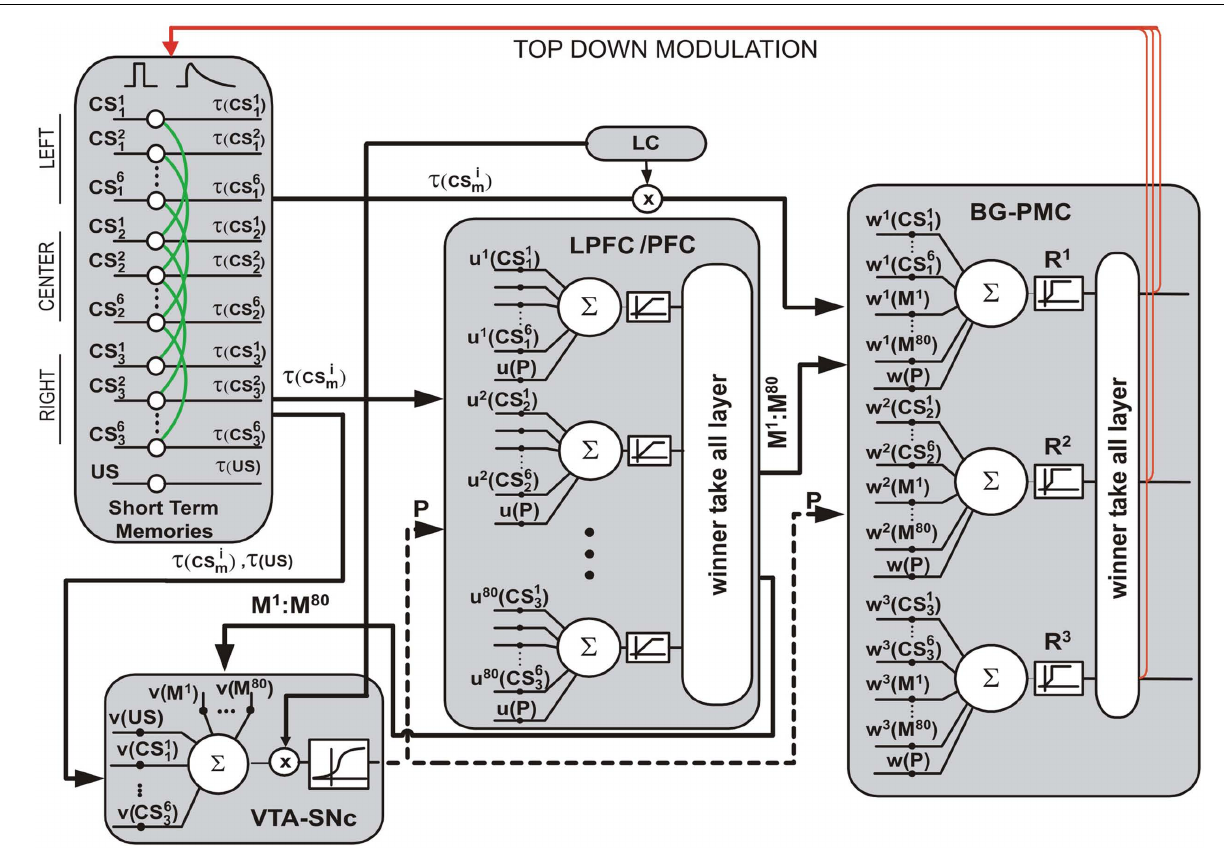
FIGURE 3 | Computational model. The input layer contains units that compute short term memories of input conditional stimuli (CS) and the reward (US).These memories are inputs to other blocks of the models.The VTA–SNc block computes P , the prediction of the US.The LC block computes a long term memory of the US, and this quantity modulates both: the excitabilityVTA–SNc neurons and the strength of visual inputs that project onto the output layer.The LPFC structure contains neurons that compute their outputs based on short term memories of the visual inputs and the value of P . Outputs of these neurons compete in a winner-take-all mechanism and project onto the output layer and onto theVTA–SNc.The